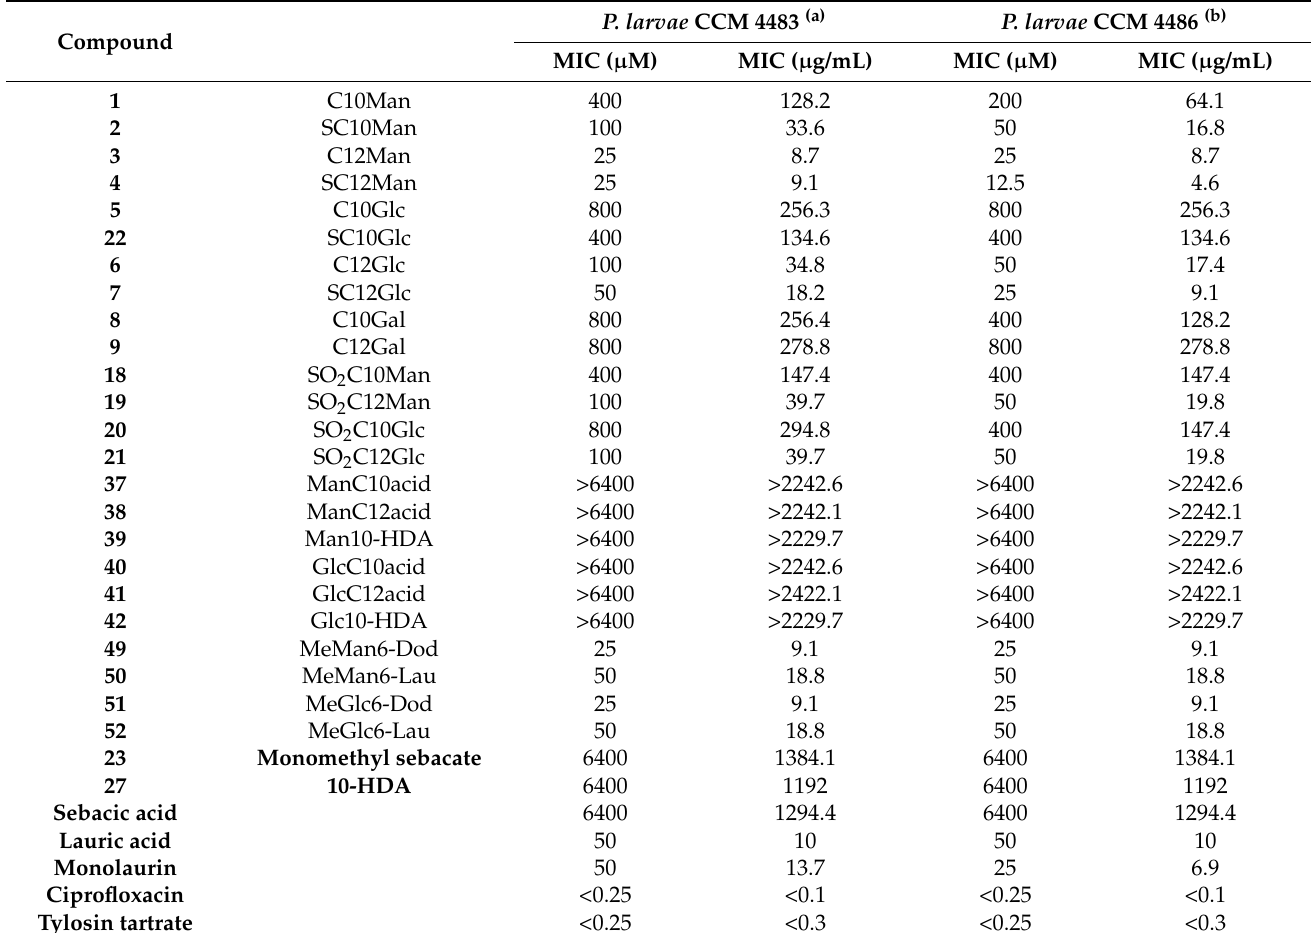
Table 1. Antibacterial efficacy of carbohydrate lipid-like derivatives and the reference compounds against two P. larvae